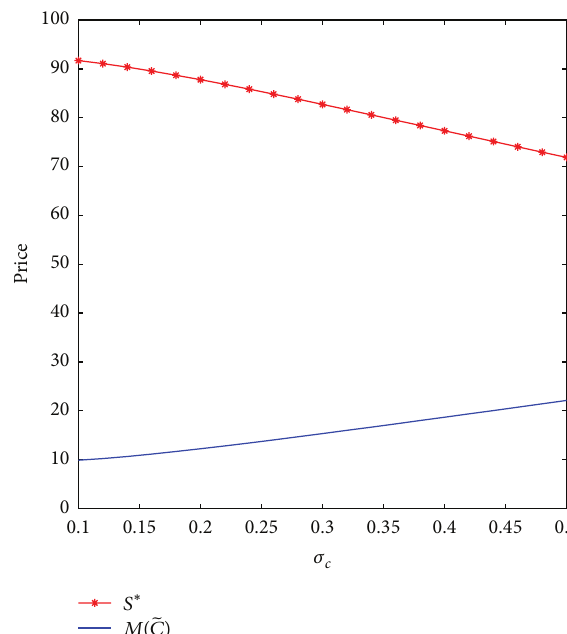
𝑀(̃𝐶) with respect to 𝜎 𝑐 . ̃𝐶